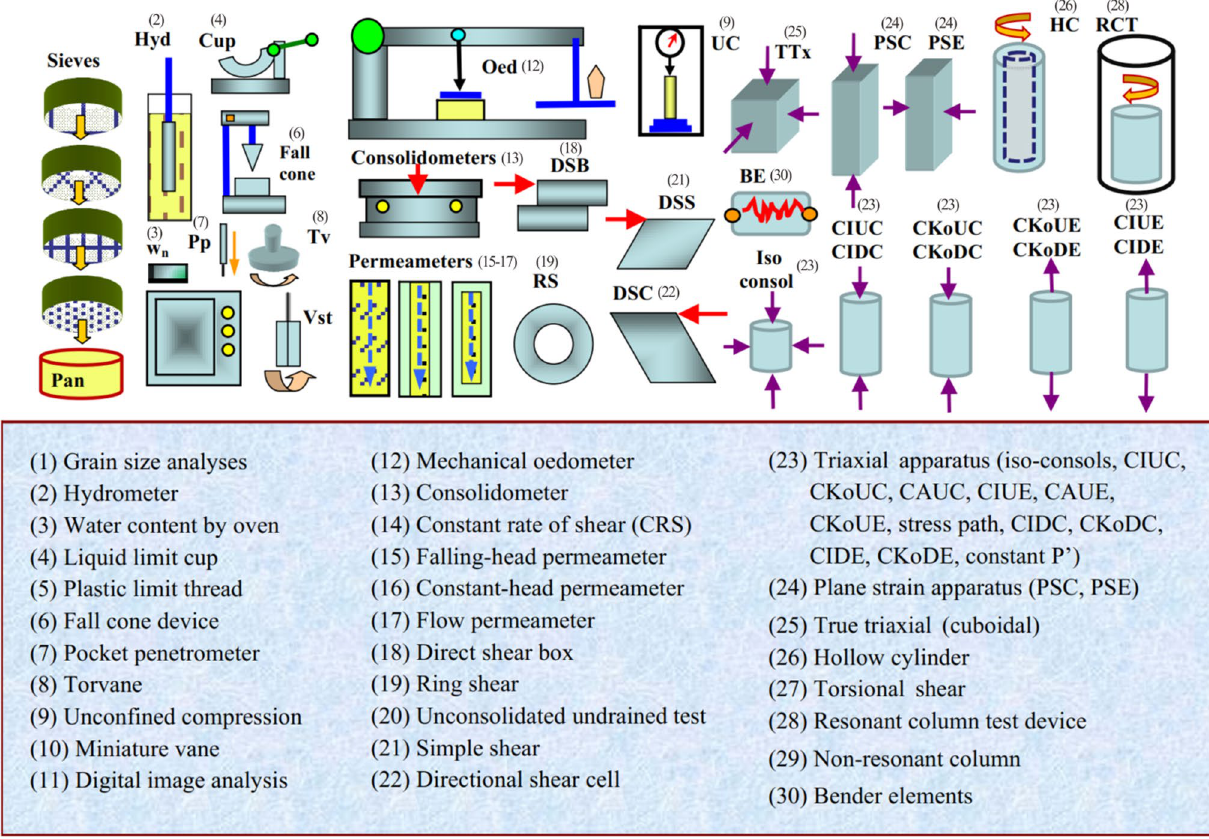
Fig. 12 Common laboratory testing techniques (modified from Mayne et al.